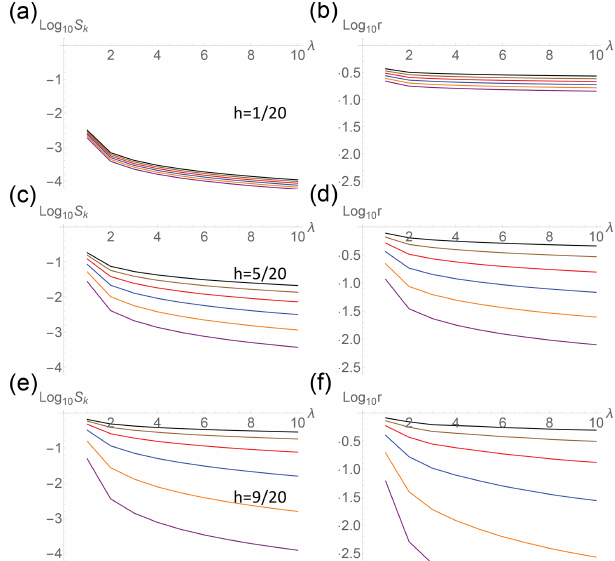
Figure 11. Panels (a, c, e) show the skill ( S k ) of pure ( α = 0) fRn forecasts (as in Fig. 10 for fGn) for fRn skill with h = 1 / 20, 5 / 20, and 9 / 20 (top to bottom sets); λ is the forecast horizon, the number of steps of resolution τ forecast into the future. Panels (b, d, f) show the ratio ( r ) of the fRn to the corresponding fGn skill. Here the result depends on τ ; each curve is for different values increasing from 10 − 4 (top, black) to 10 (bottom, purple) and increasing by a factor of 10 (the red set in the bottom plots with τ = 10 − 2 ; h = 9 / 20 are closest to the empirical values).